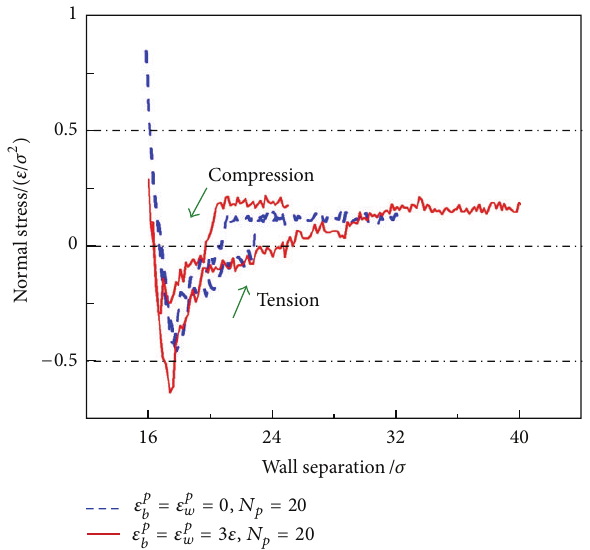
Figure 38: The normal stress of both nonfunctional (dashed lines) andfunctional(solid)PFPEfilmswith 𝑁 𝑝 = 20 duringthesimulated nanomechanics, that is, “compression” and “tension.”